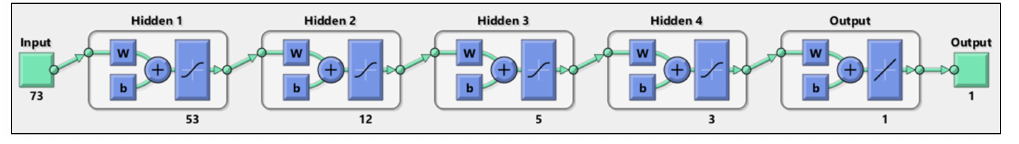
Figure 8. Neural network layout.